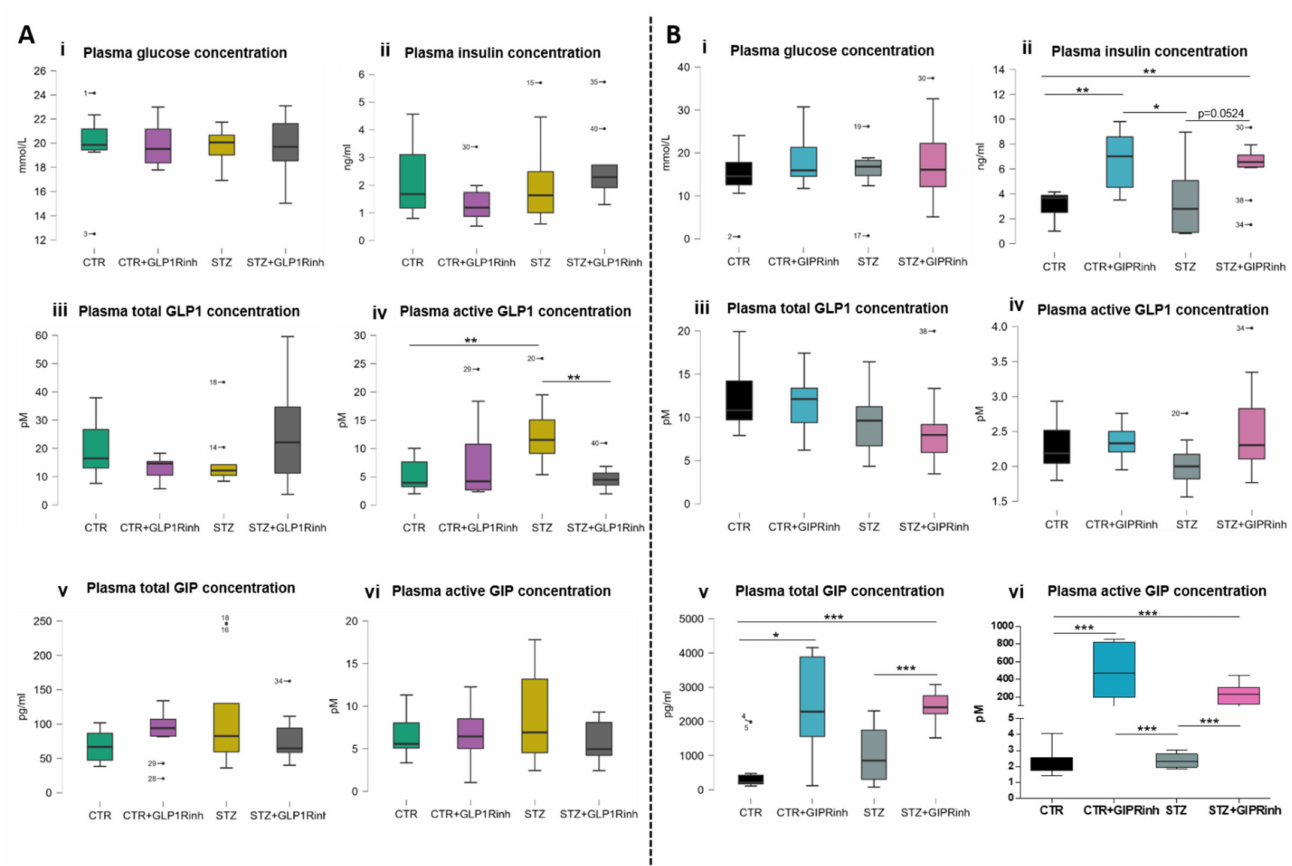
Figure 2. Glucose, insulin, glucagon-like peptide-1, and gastric inhibitory polypeptide plasma concentrations. One month after intracerebroventricular (icv) streptozotocin (STZ) or vehicle (CTR) administration, rats were injected icv with 85 µ g/kg of glucagon-like peptide-1 receptor antagonist (exendin fragment 9-39, GLP1Rinh; experiment 1) or 85 µ g/kg of gastric inhibitory polypeptide receptor antagonist (Pro3-GIP, GIPRinh; experiment 2) dissolved in saline or with saline only (CTR and STZ). Animals were sacrificed 30 min after icv administration and blood was sampled for analysis of glucose ( i ), insulin ( ii ), total ( iii ) and active ( iv ) GLP1, and total ( v ) and active ( vi ) GIP concentrations in plasma ( A , B ). Values are presented as boxplots with marked outliers and data analyzed by a non-parametric Kruskal–Wallis one-way ANOVA test followed by a Mann–Whitney U test (* p < 0.05; ** p < 0.01; *** p <